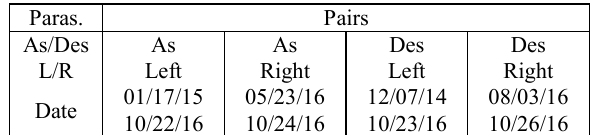
Table 1. Information of the used SAR data